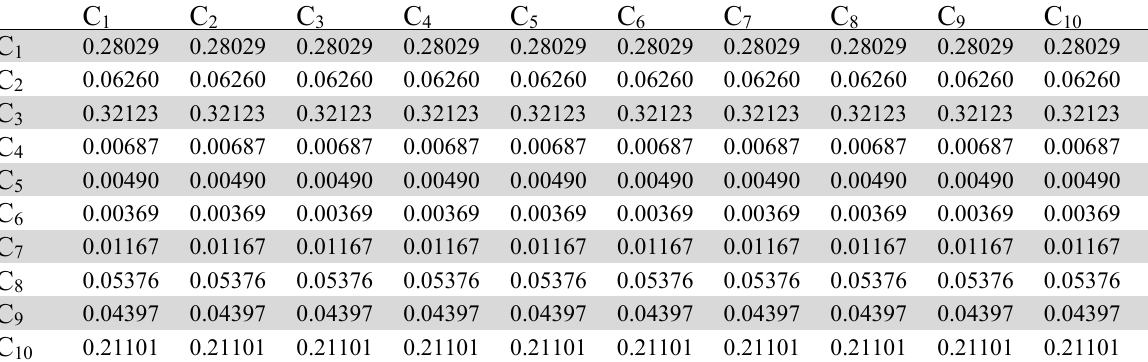
Limit matrix for DM 1